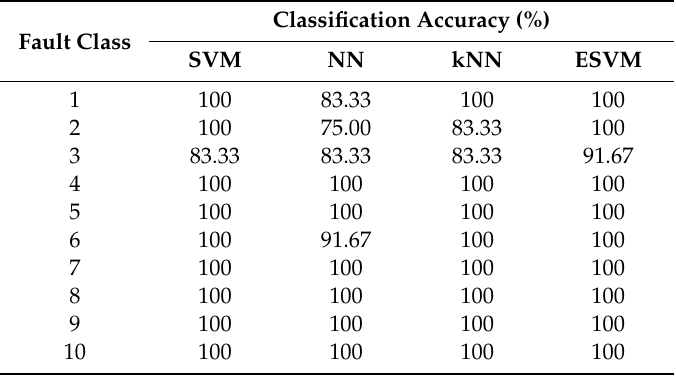
Table 5. The bearing fault diagnosis results by di ff erent classifiers.